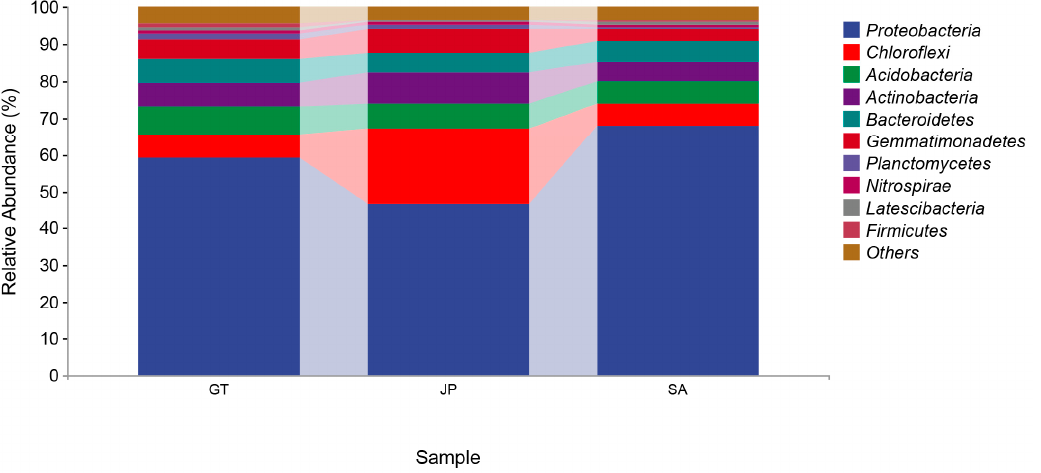
Figure 3. Taxonomic composition of soil bacterial communities at the phylum level in bare flats (GT), Sueada salsa areas (JP), and S. alterniflora Loisel areas (SA).